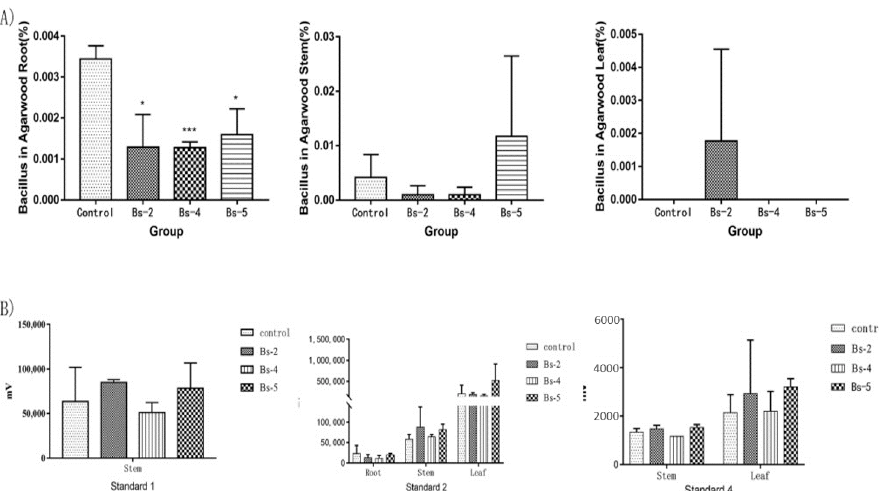
Figure 6. Effect of saprophytic Bacilli on Aquilaria sinensis . ( A ): The suspension of Bs-2, Bs-4 and Bs-5 was diluted 100 times with sterilized water, and sprayed into three other Aquilaria sinensis except the control. Then Aquilaria sinensis was incubated for a month and replicons representing bacterial diversity (V3-V4 region) in leaves, stems and roots were sequenced. ( B ): The extracts of roots, stems and leaves of each group were tested by HPLC to determine the contents of agarotetrol, 6,7-dimethoxy-2-(2-phenylethyl)chromone and hydrocinnamic acid. (Standard 1: agarotetrol; Stan- dard 2: 6,7-dimethoxy-2-(2-phenylethyl)chromone; Standard 4: hydrocinnamic acid). Values are expressed as mean ± SEM, * p < 0.05, and *** p < 0.0001 vs.